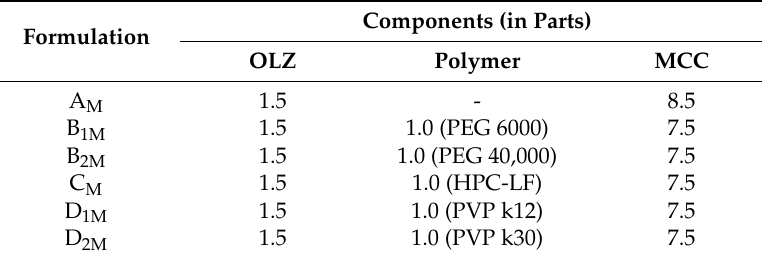
Table 4. Formulations considered in the manufacture of pellets 1 .